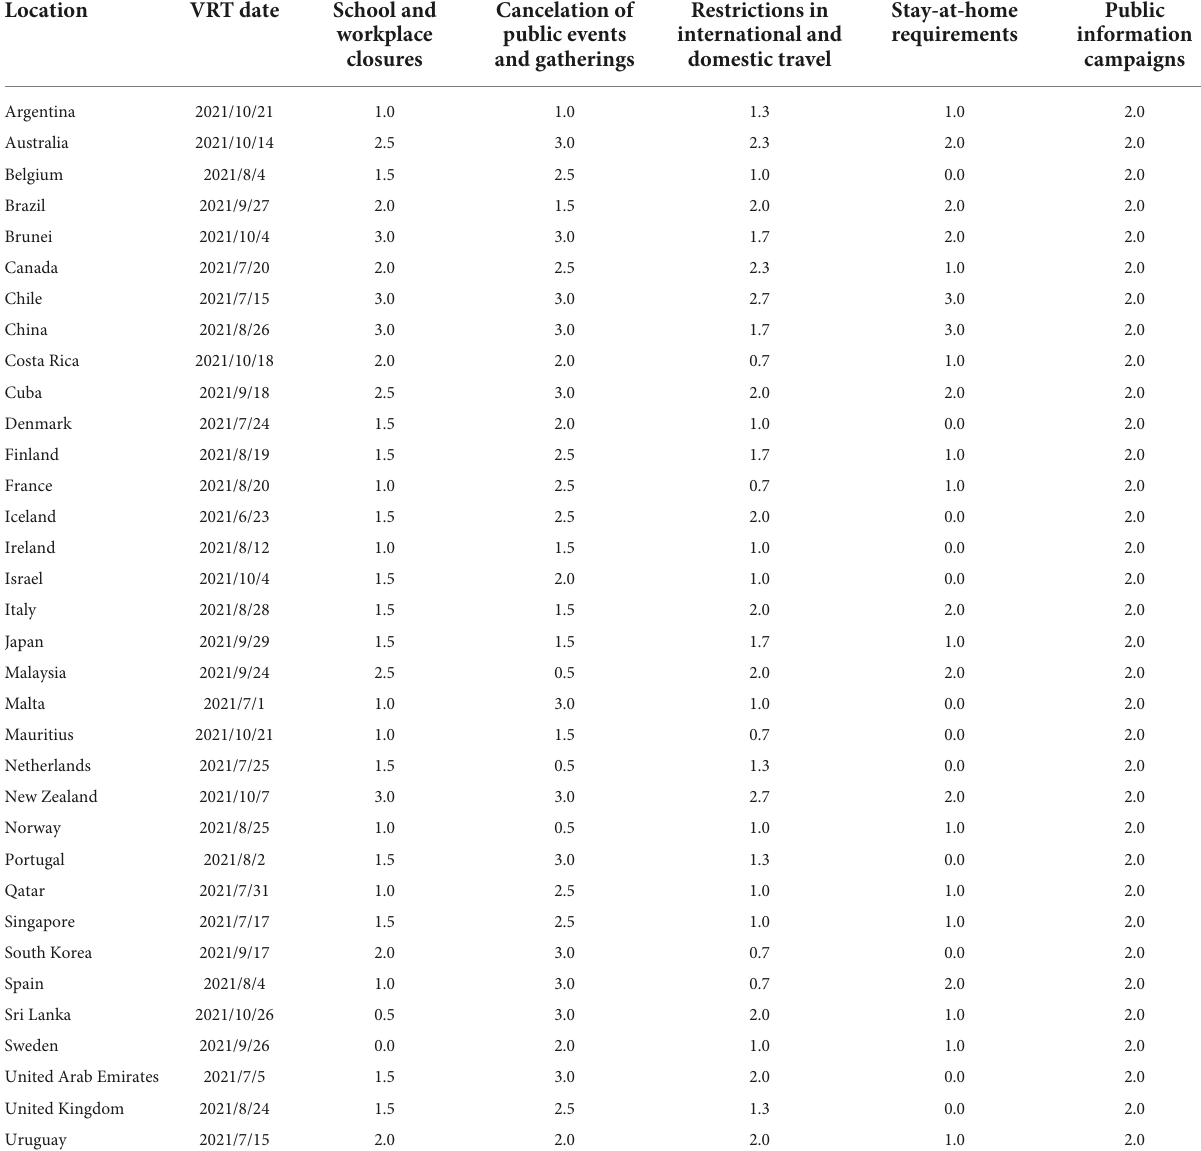
TABLE 2 Implementation of non-pharmacological intervention combinations at the date the COVID-19 vaccination rate threshold was reached in 34 countries. Location